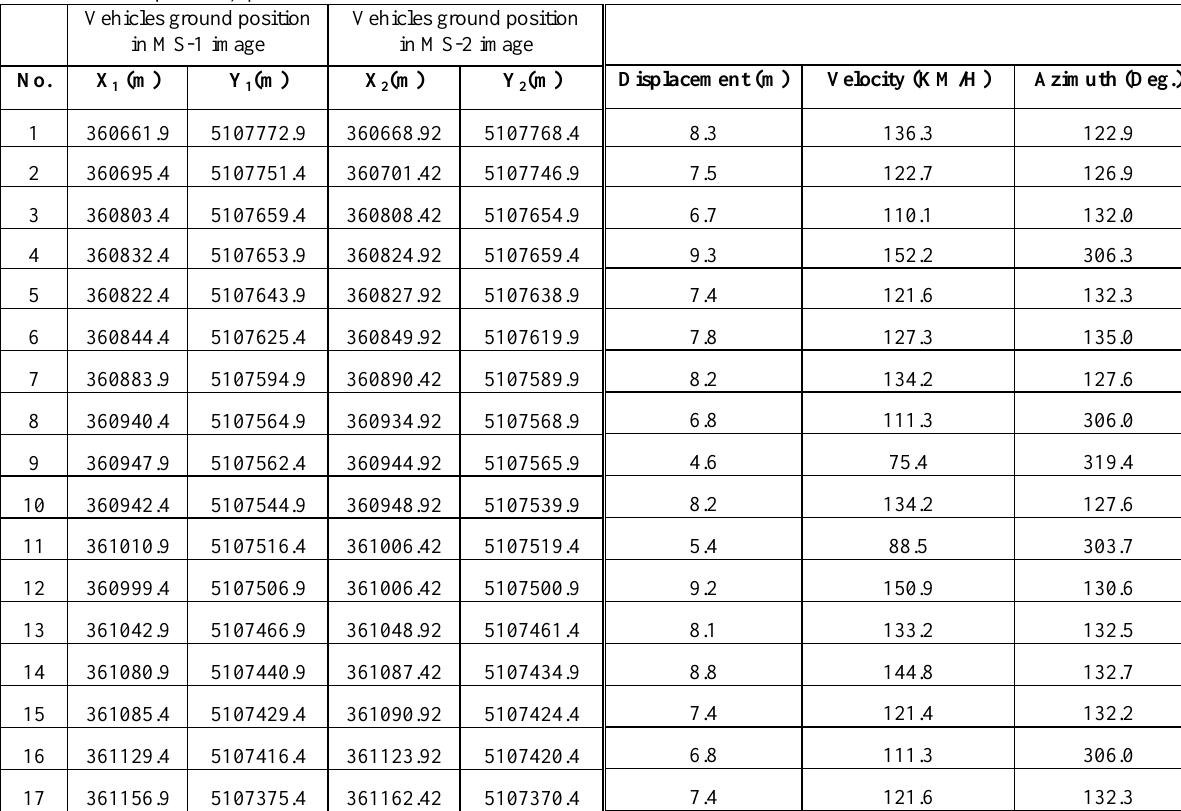
Table 2: Ground position, speed and direction of the vehicles Vehicles ground position Vehicles ground in MS-1 image